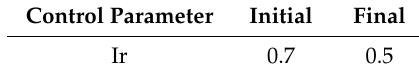
Table 3. The Resilience Index (Ir) comparison between the original network and the sectorized network.